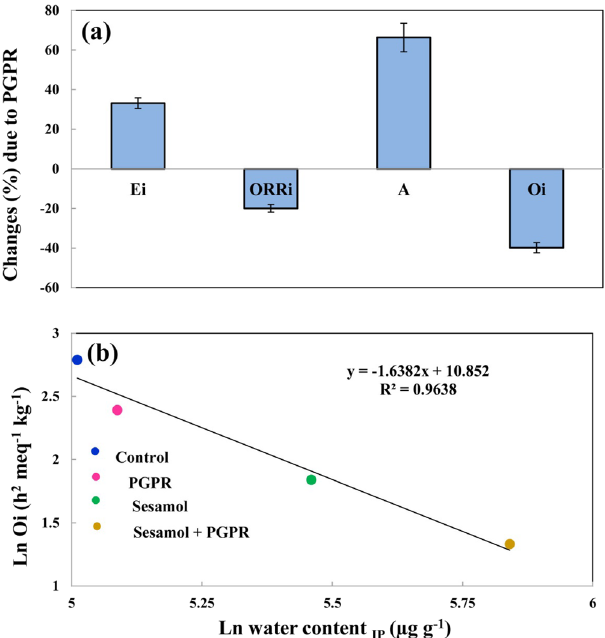
Figure 3. ( a ) Changes (%) in the kinetic parameters ( E i effectiveness of sesamol in the initiation stage, ORR i oxidation rate ratio in the initiation stage, A antioxidant activity, O i oxidizability in the initiation stage) of purified sunflower oil in the presence of polyglycerol polyricinoleate (PGPR), and ( b ) relationship between the O i value of sunflower oil samples and water content at the induction period (IP) point.